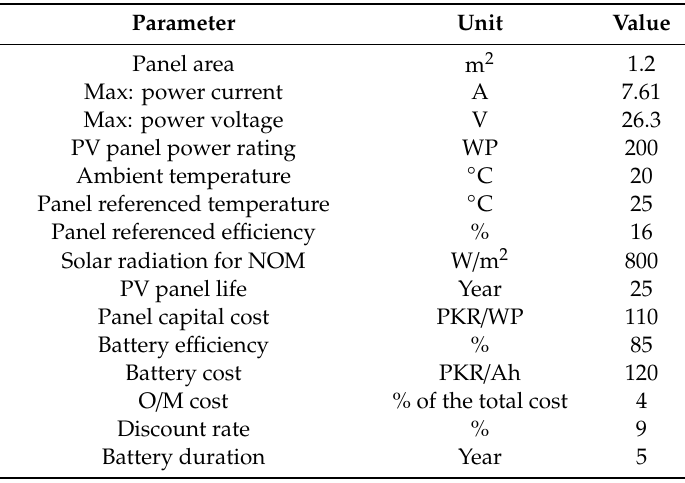
Table 5. Parameters employed in the